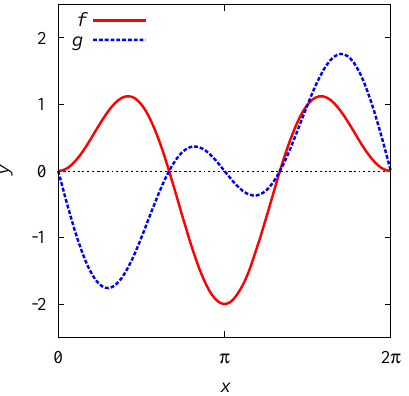
Figure 3. Graphs of the functions f and g as defined in Eq. (5). The eigenvalues of the equilibrium x F = (F,...,F) are given by λ j = − 1 + Ff ( 2 πj/n) + Fg( 2 πj/n)i for j = 0 ,...,n − 1. The shapes of the graphs of f and g imply that the equilibrium x F can only lose stability through either a Hopf or a double-Hopf bifurcation for F > 0 (see main